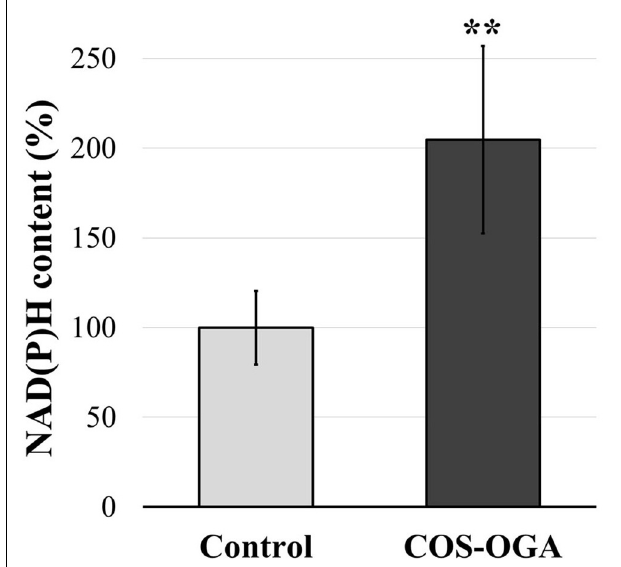
FIGURE 5 | Stomatal conductance of tomato leaves after three sprayings with chitooligosaccharides–oligogalacturonides (COS-OGA; 62.5 mg/l). The average stomatal conductance of the elicited plants is expressed as a percentage of the control ± standard deviation ( n = 12). **indicates a statistically significant difference to control according to Student’s t test ( p < 0.01, R ).